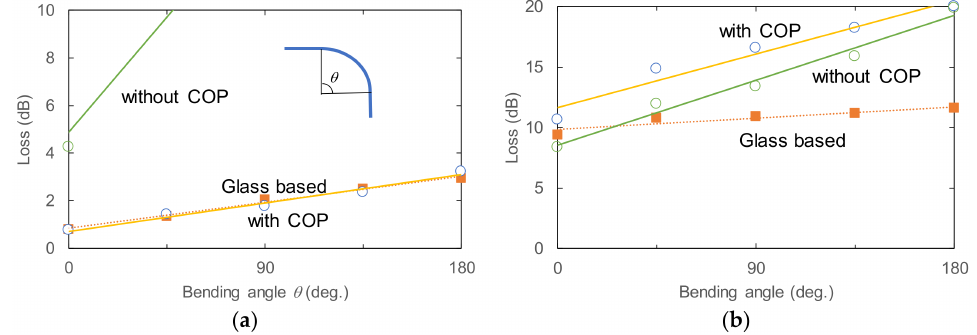
Figure 6. Bending losses of the SUS COP-coated fibers measured with ( a ) 10.6- µ m CO 2 laser and ( b ) 532-nm laser. The inner diameter of the fiber is 550 µ m and the length is 1